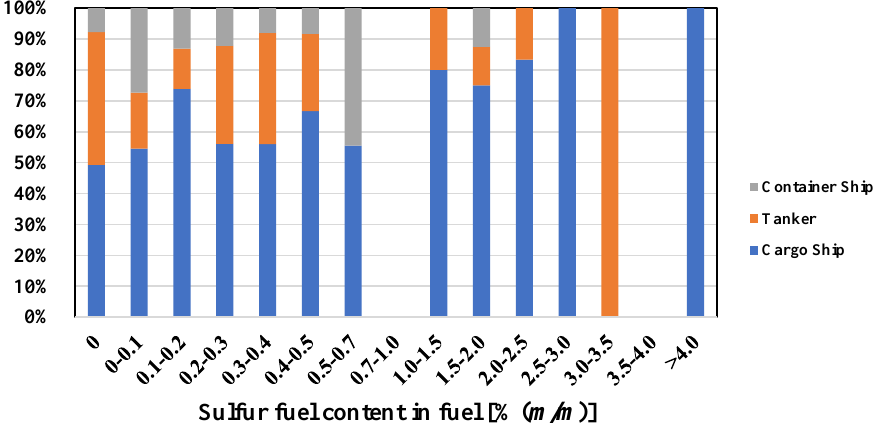
Figure 6. Comparison of compliance levels between ship types.